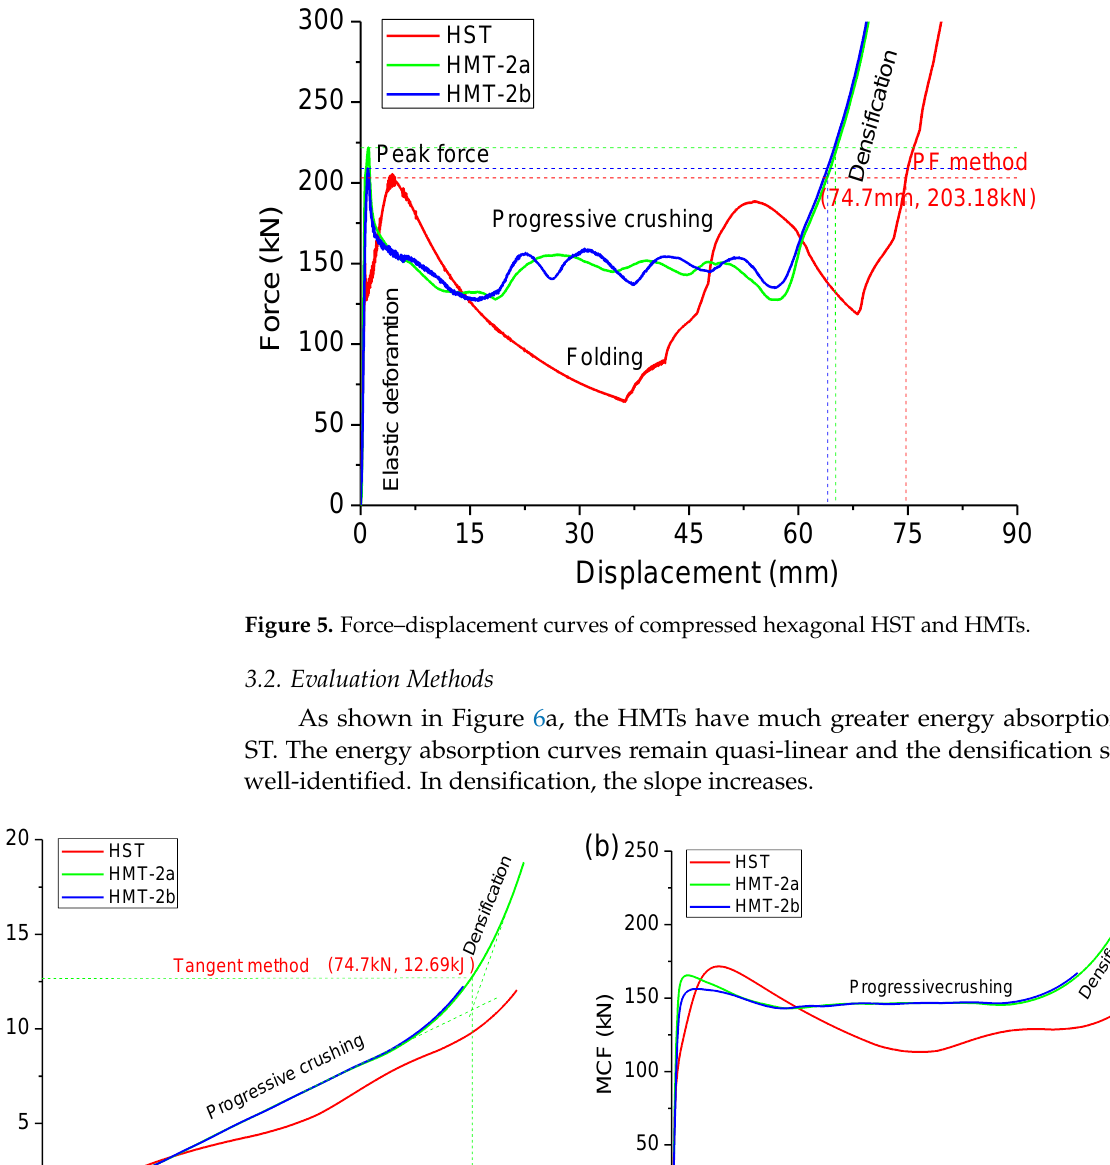
Shorter folding wavelength results in more stable deformation curves, as shown in Figure 5, where the force–displacement curves are displayed. The displacement curve of the HST has great fluctuations with two waves, while the HMTs have more stable deformations with four waves. The fluctuation amplitude depends on the number of folding waves. Obviously, the amplitude of displacement oscillation of the ST is much larger, which will weaken its energy absorption.